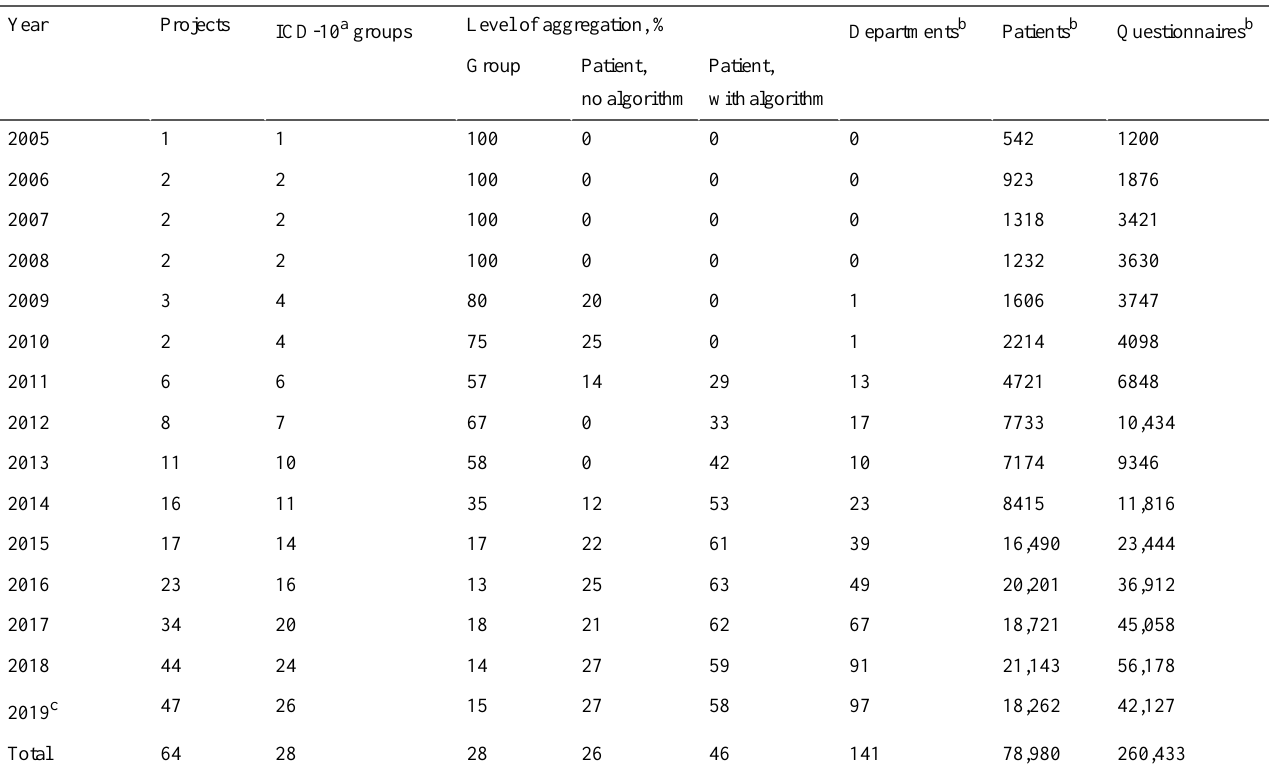
a ICD-10: 10th edition of the International Statistical Classification of Diseases and Related Health Problems. b Patients and departments may be involved in more than one disease-specific project. c As of September 8,